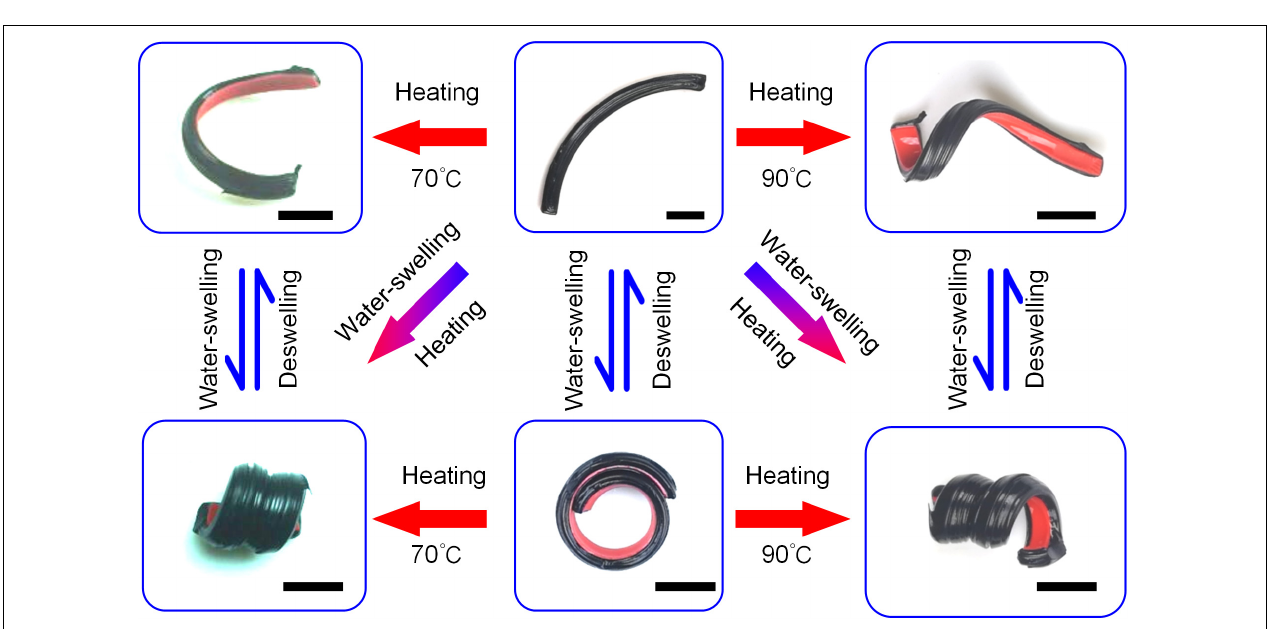
FIGURE 8 | PU-SMPVC bilayer structure with a gradient PU layer thickness, which can produce an involute shape undergoing water-swelling or heating.